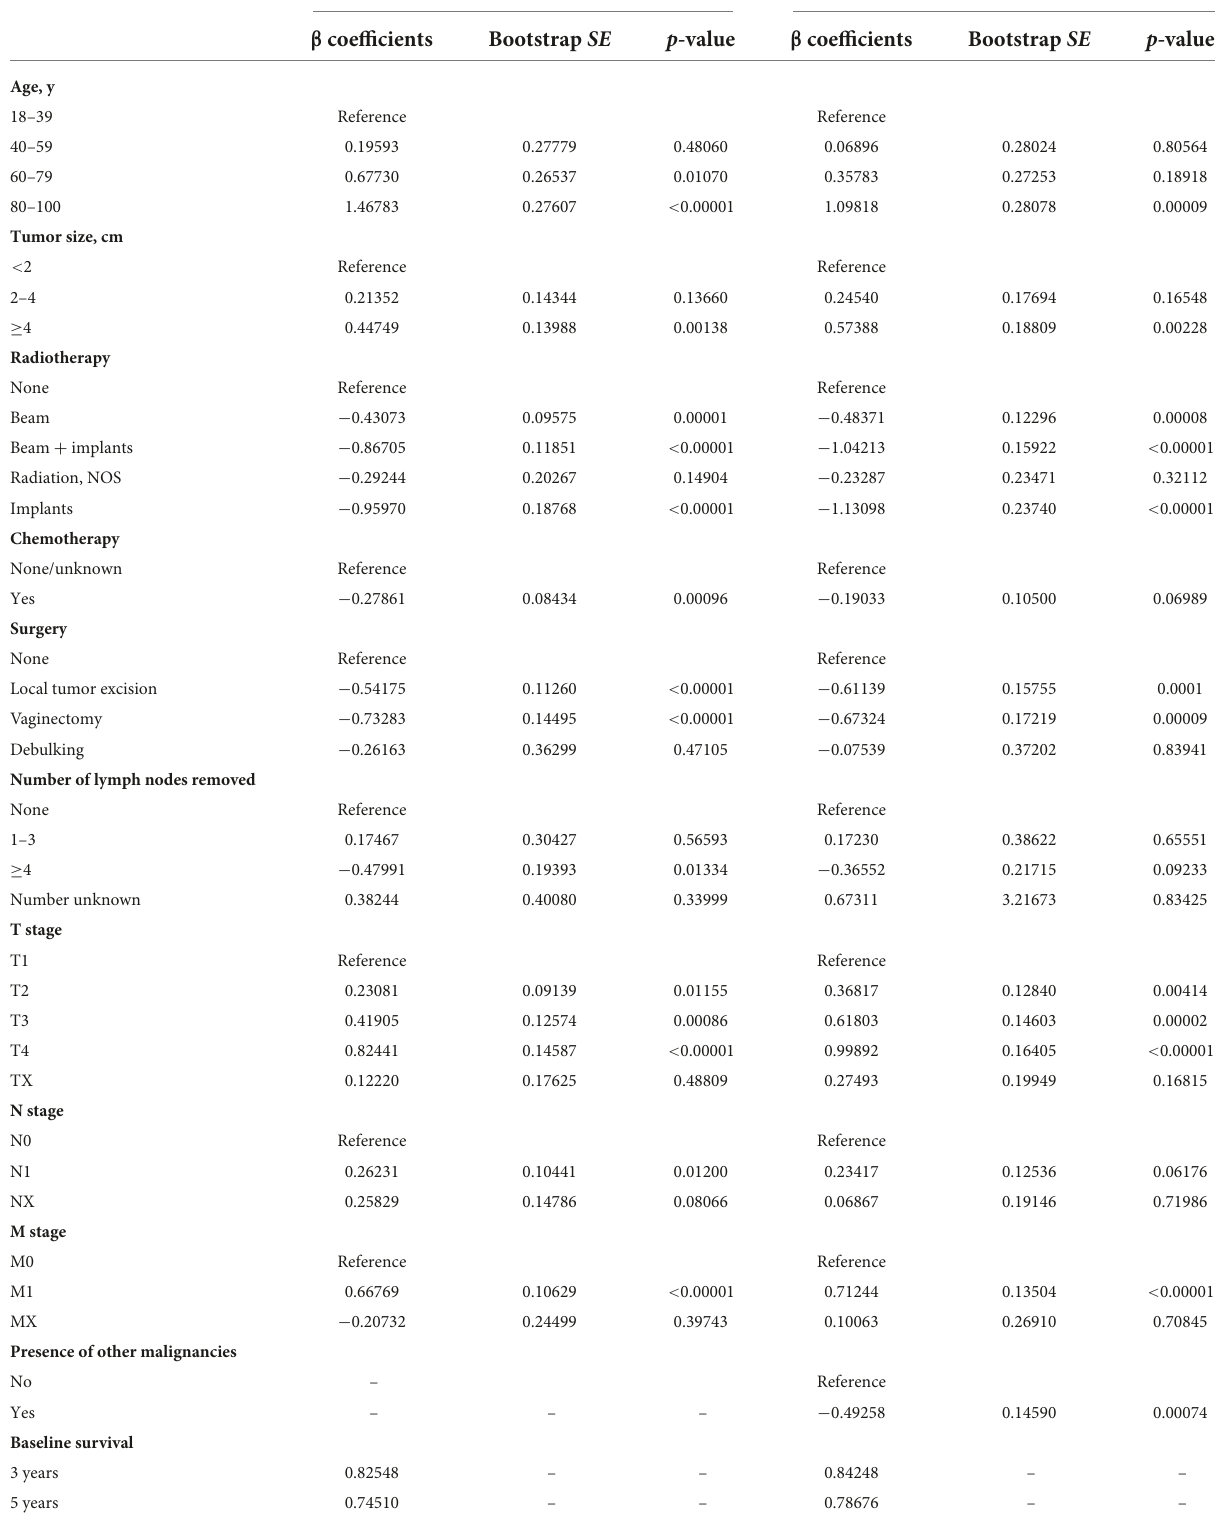
TABLE 3 Beta coefficients and their bootstrap standard errors of the final overall and cancer-specific survival models calculated within the imputed training